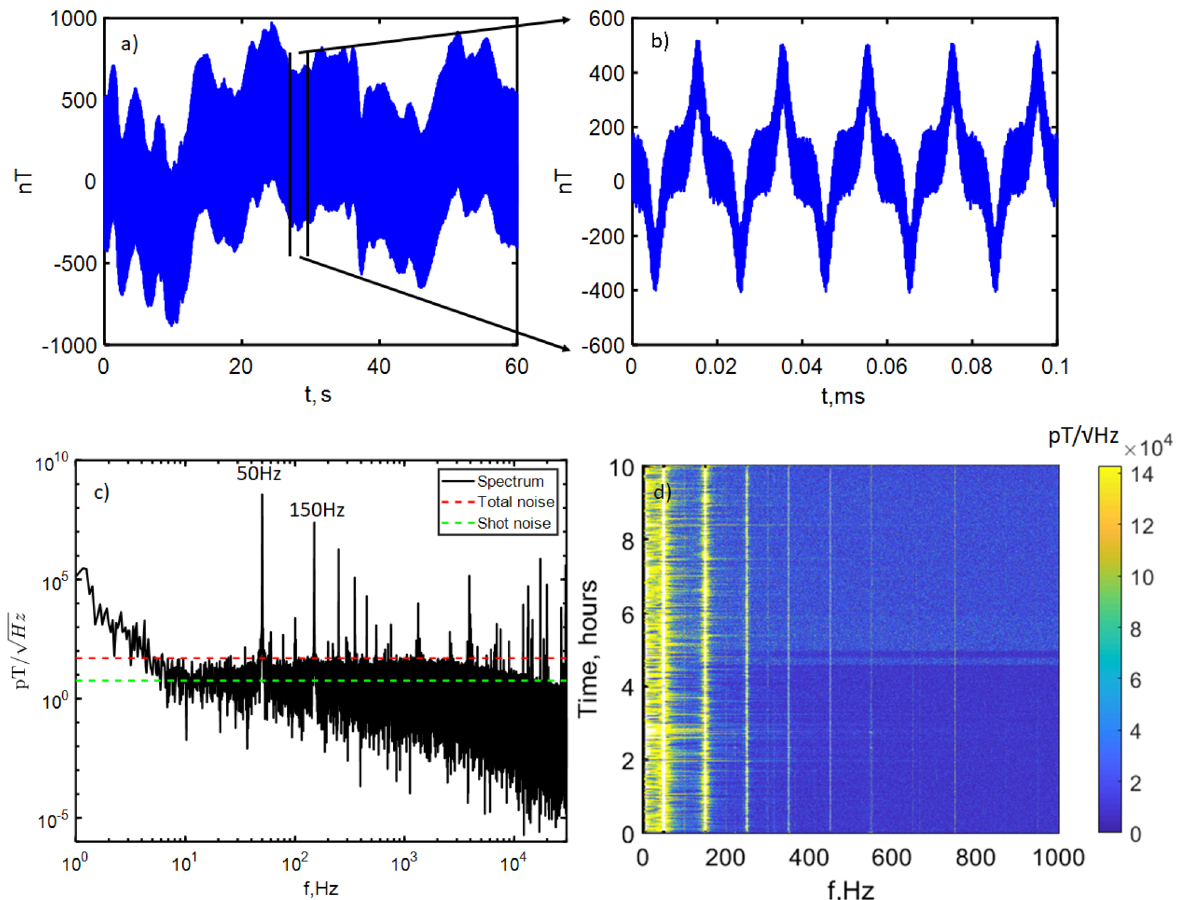
Figure 2. Demonstration of high dynamic range, bandwidth and sensitivity to magnetic field. ( a ) The raw unfiltered magnetic signal for a full 60 s iteration and ( b ) a zoomed 0.1 s segment of the same iteration. The signal was dominated by low frequency and DC laser power drift ( < 5 Hz), 50 Hz and 150 Hz noise from mains electricity and higher frequency ( > 10 kHz) noise and ranges between the magnetometer. ( c ) Spectral density in pT/ √ Hz for a single 60 s iteration and ( d ) a spectrogram of repeated 60 s acquisitions over 10 h. The sensitivity floor is approximately 50 pT/ √ Hz with f( the lock-in amplifier low pass filter. Also indicated are calculations of the total noise, which includes electronic and shot noise, and of the estimated shot noise level alone. Many sources of background magnetic noise can be seen to peak well above this